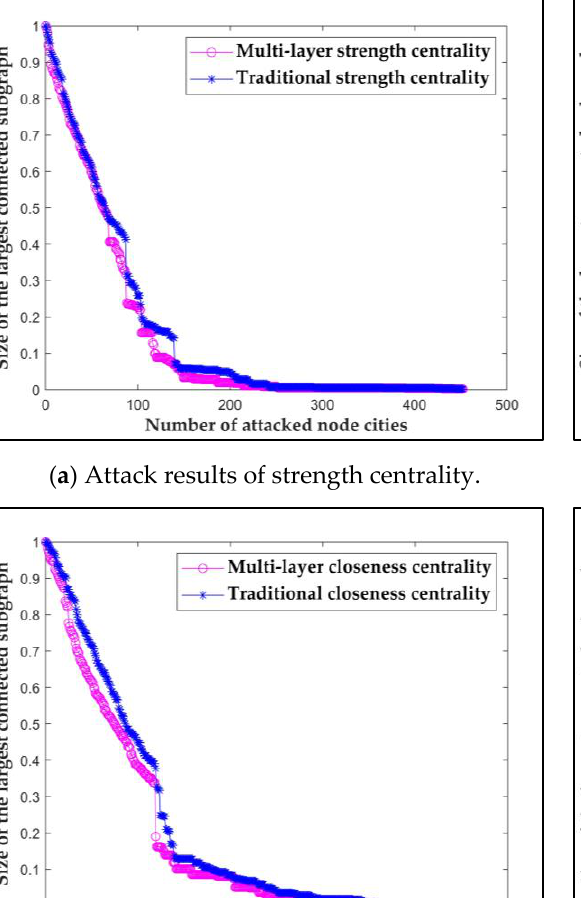
Figure 9. Attacks results of different comprehensive centrality. Second, analyze attack result of traditional comprehensive centrality and the attack result of multi-layer comprehensive centrality.  with the multi-layer comprehensive centrality attack is shown in the blue star line in Figure 9. The traditional comprehensive